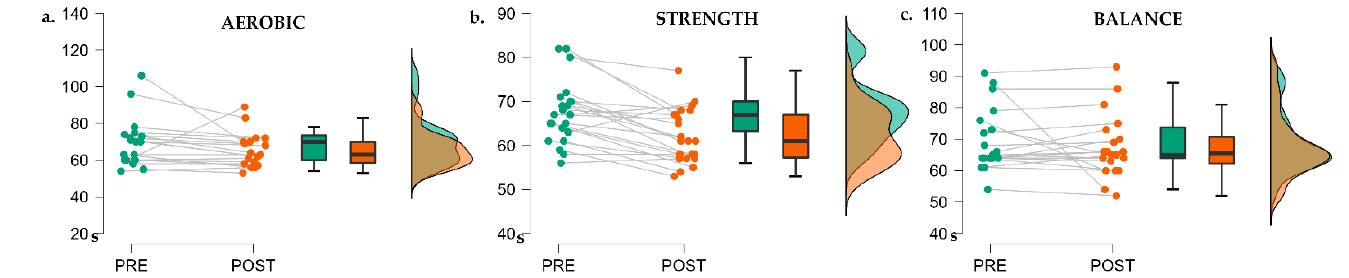
Figure 1. The raincloud plots for the different exercise sessions in the Word Condition. ( a ) Aerobic session. ( b ) Strength session. ( c ) Balance session. Time is measured in seconds ( Y -axis).